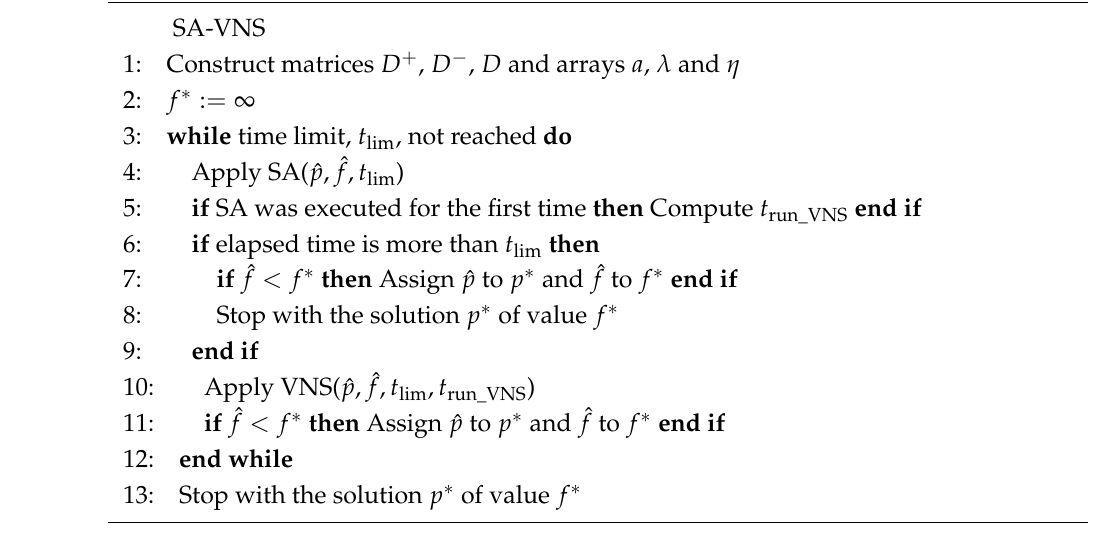
Algorithm 1 Integrating simulated annealing and variable neighborhood